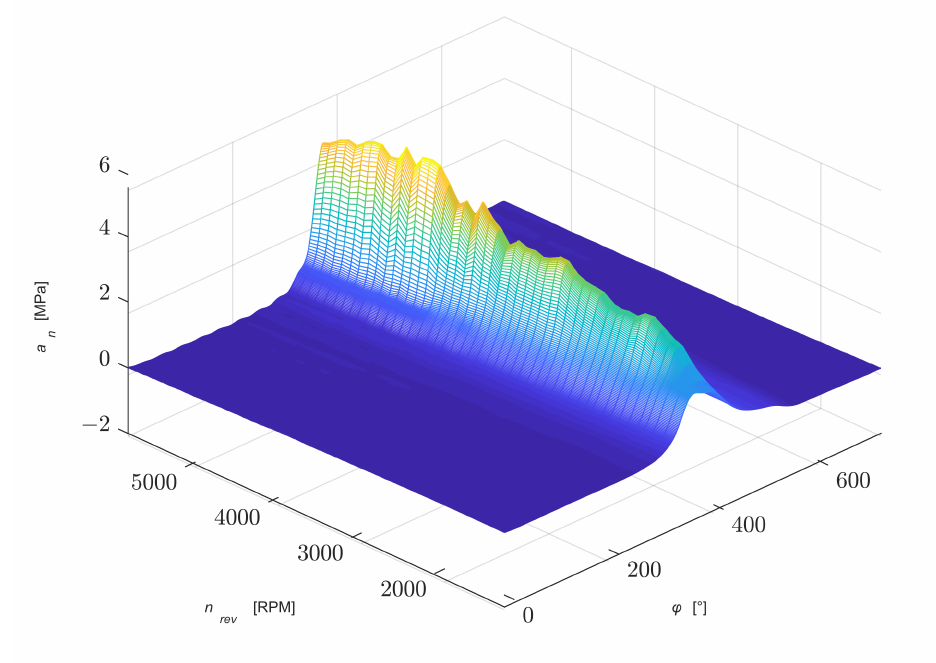
Figure 16. Waveforms of pressure changes as a function of the shaft rotation angle and rotational speed determined by a Fourier series.